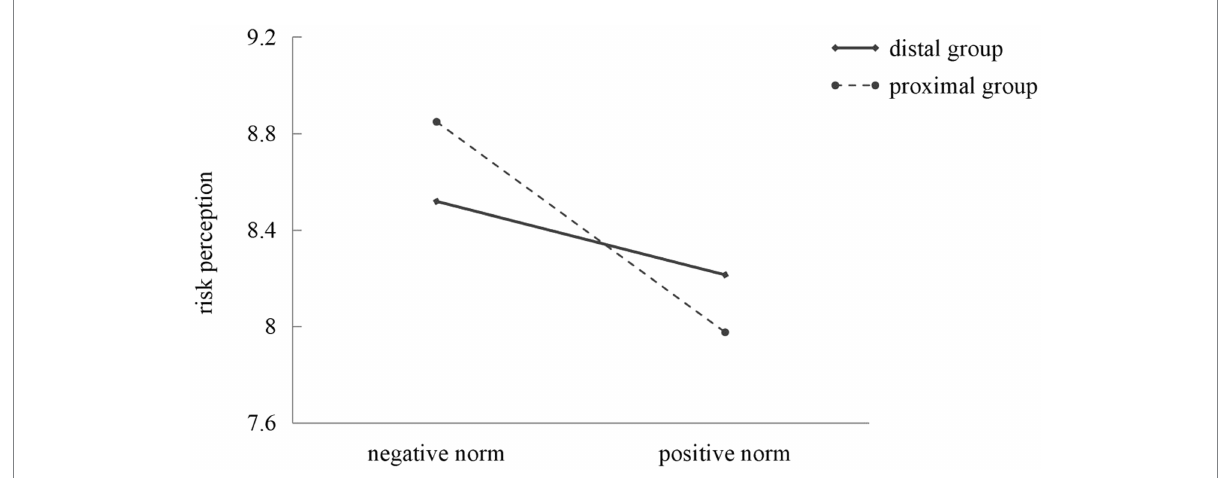
FIGURE 4 The interaction effect of the property and the reference group of descriptive norms on risk perception.